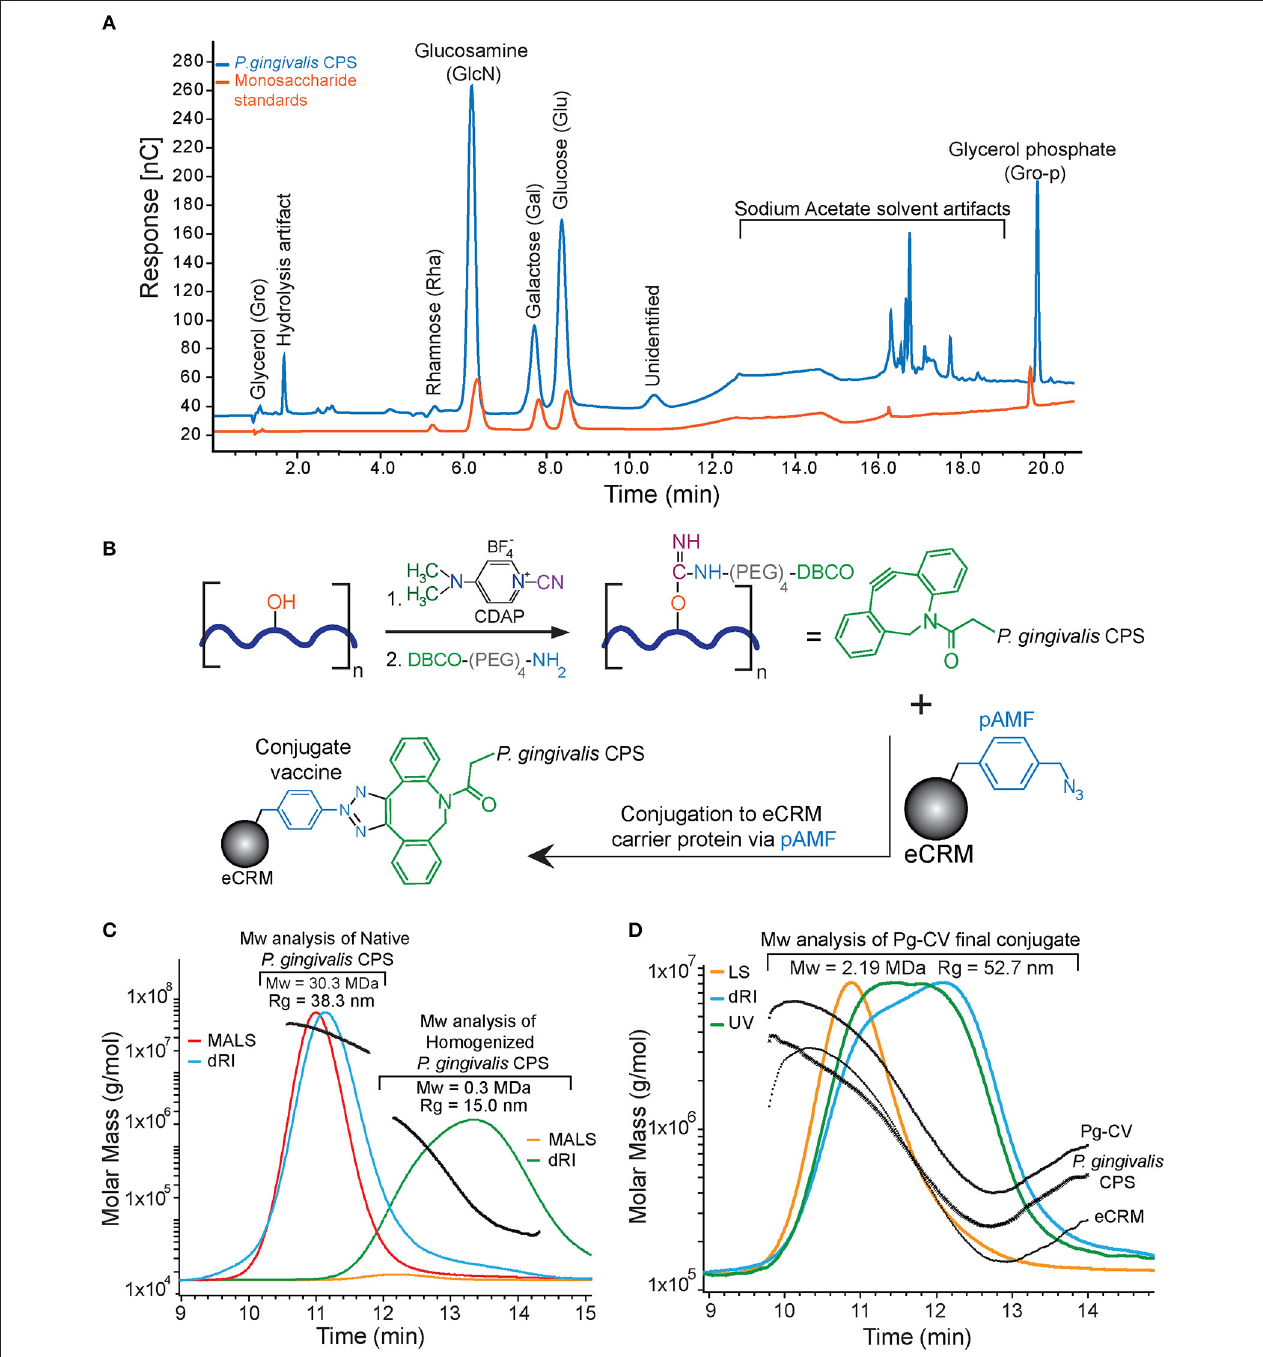
FIGURE 1 | Porphyromonas gingivalis A7436 CPS characterization, a conjugation scheme, and analysis of Pg-CV. (A) HPAEC-PAD monosaccharide analysis. The Pg-CPS (blue trace) and the monosaccharide reference mixture (orange trace) are presented. Major peaks are labeled with the monosaccharide identity based on retention time and referenced against the reference mixture. (B) The schematic conjugation process. The Pg-CPS (dark blue heavy line) with the reactive hydroxyls (red) on the monosaccharides in the repeat unit. Hydroxyl groups were activated with CDAP, resulting in the formation of a cyanoester reactive intermediate. This cyanoester reacts with the terminal amine of the DBCO-PEG4-NH2 linker, forming an amide bond to the polysaccharide via the DBCO moiety (green). eCRM ® (gray sphere) drawn with one representative pAMF site reacts with the DBCO group, forming the final covalently linked polysaccharide-protein vaccine product: Pg-CV. (C) HPLC/SEC-MALS-RI chromatograms of the full-size and size-reduced Pg-CPS. A light scattering signal is a colored red and the refractive index in blue. The later-eluting orange and green peak traces centered between 12 and 14min represent the light scattering and refractive index signals, respectively. Calculated MW for each eluting time fraction of the chromatograms is overlaid onto the peaks in black. (D) HPLC/SEC-MALS-RI-UV chromatograms for the final Pg-CV product. The light scattering signal (orange trace), refractive index (blue trace), and the 280-nm UV signal (green trace) are depicted. Average MW of the final Pg-CPS/eCRM ® conjugate product is listed above the peaks and was determined to be 2.19 MDa for final Pg-CV conjugate. The MW results of the protein conjugate analysis are overlaid (black traces) and labeled accordingly. Frontiers in Oral Health |